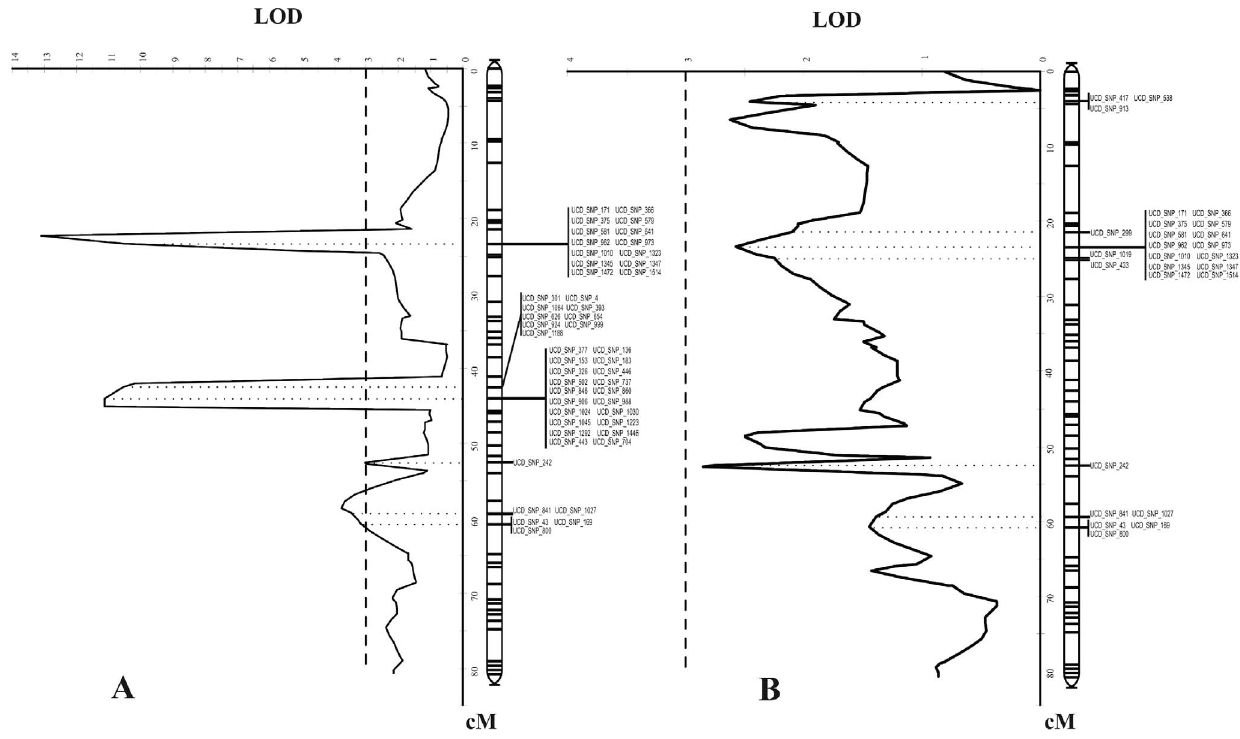
Figure 3. Comparison of candidate QTLs between years. QTLs on linkage group 1, using two years data (A) or three years data (B).